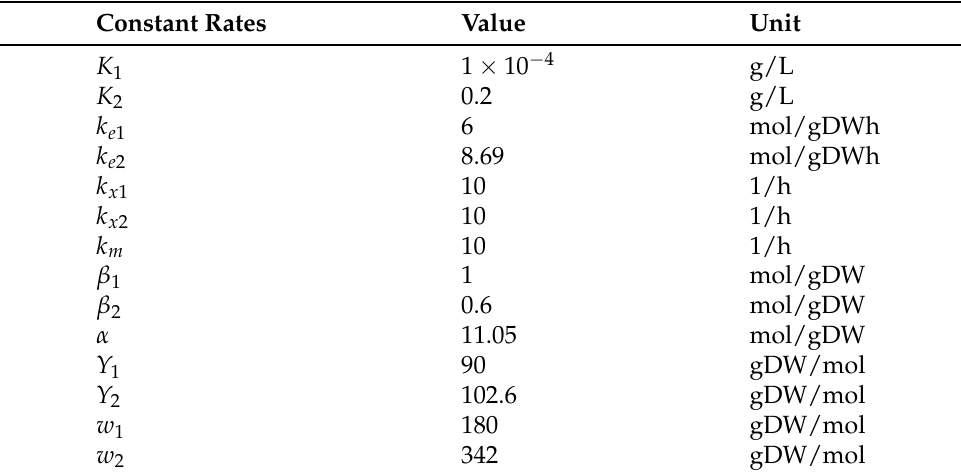
Table 1. The set of all parameters of the kinetic model that are taken from literature [28].